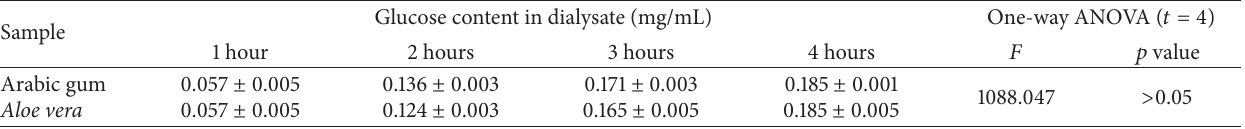
Table 2: Glucose content in dialysate.